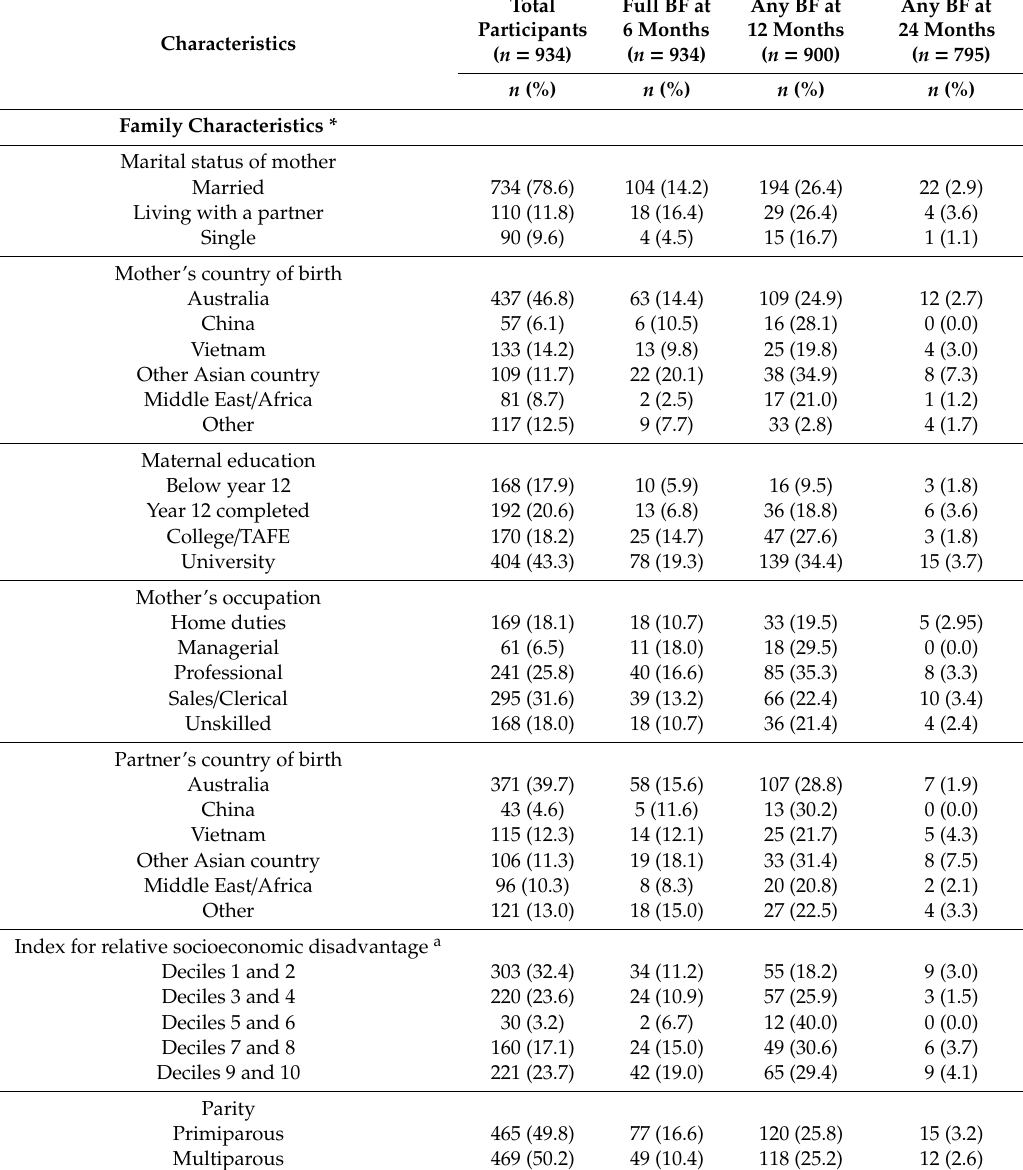
Table 1. Family and infant characteristics of the participants with breastfeeding duration up to 24